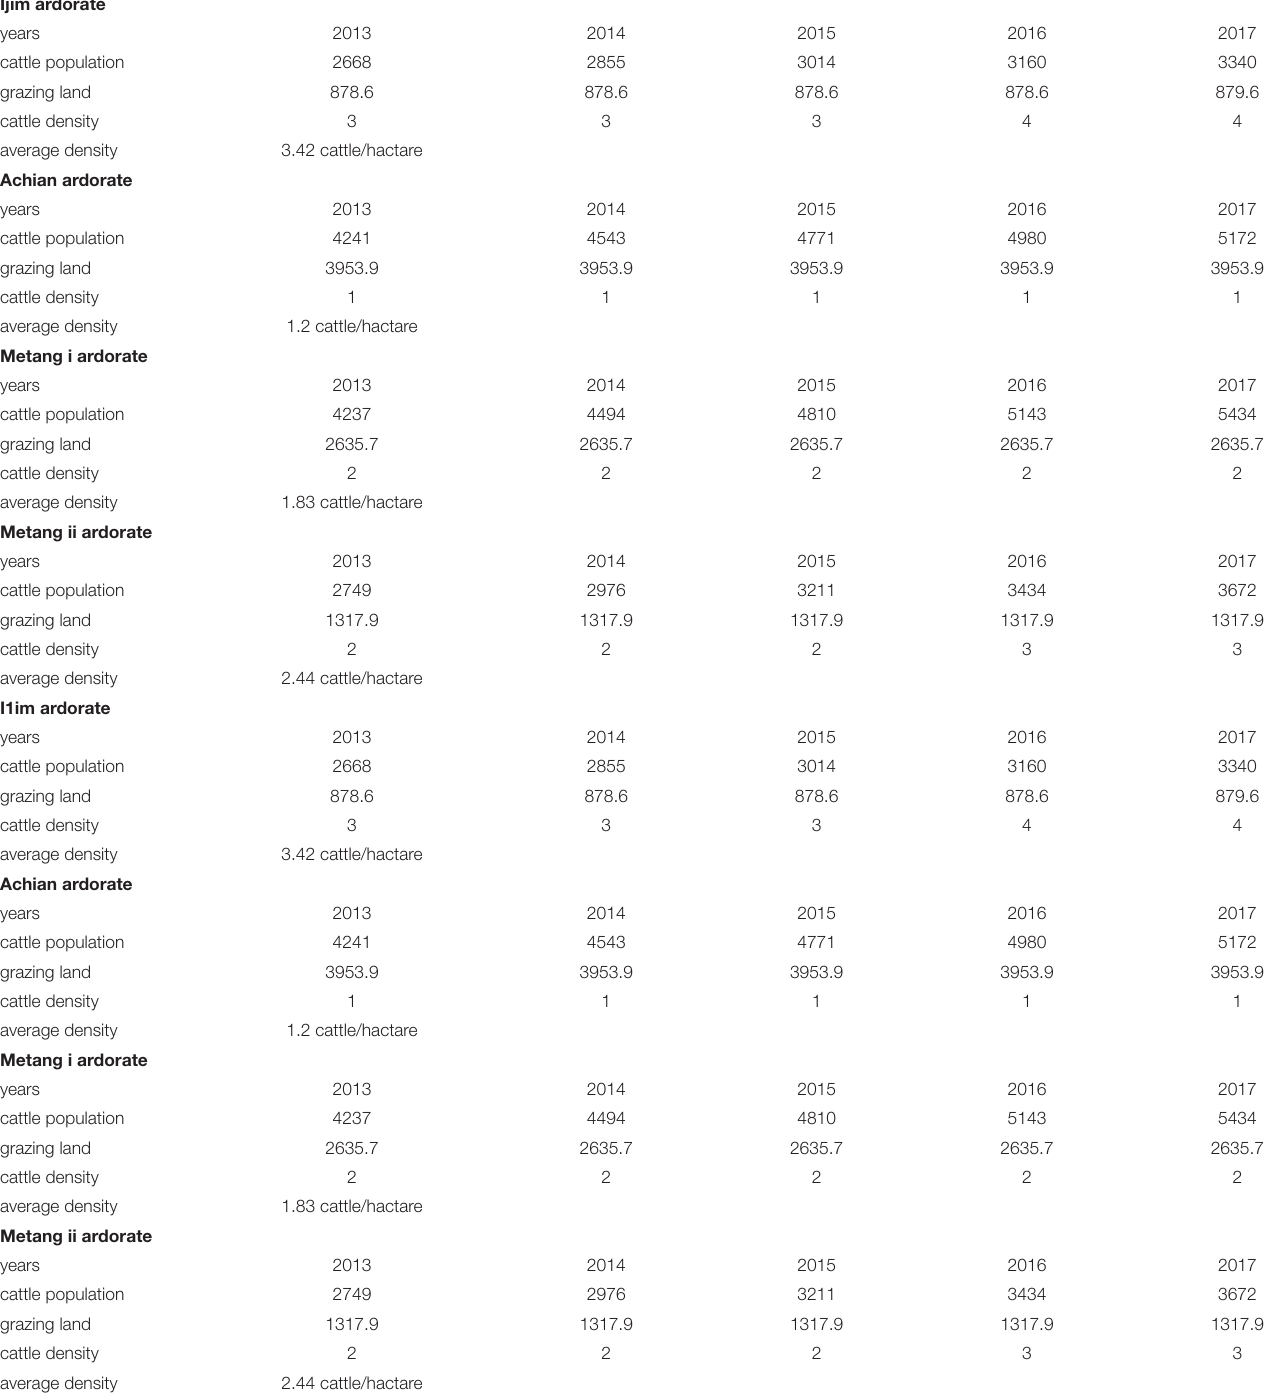
TABLE 2 | Determining carrying capacity per grazing